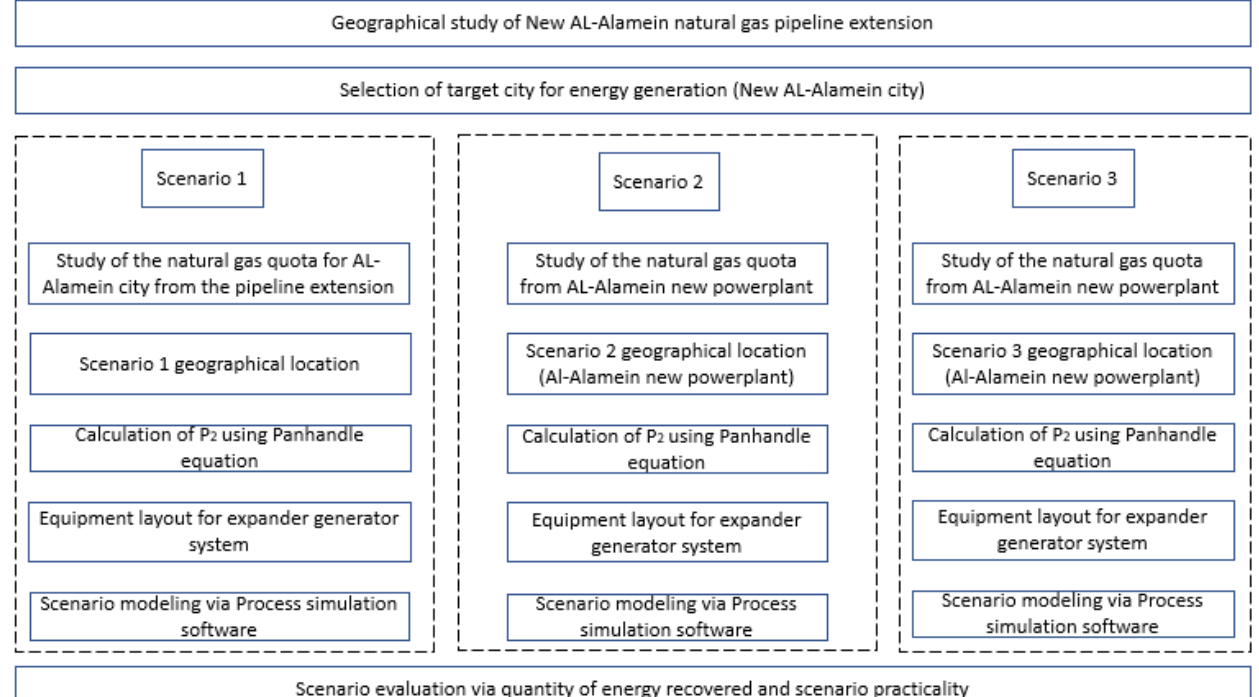
Figure 3. The proposed energy recovery scenarios.